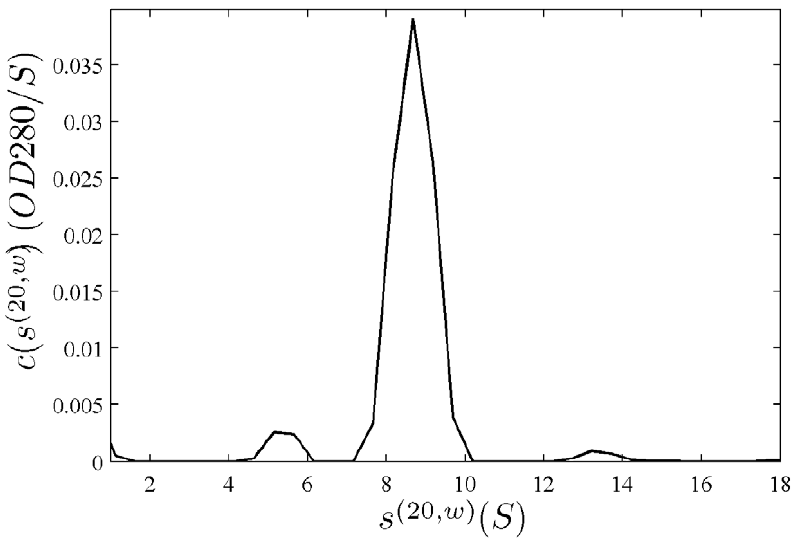
Figure 2. Sedimentation coefficient distribution for the global analysis of the absorbance data from the phosphorylase sample (Figure 1). Relative scaling factors a 2 = a 1 and a 3 = a 1 were 1.039 and 1.136 (see Eq. 19), indicating slightly different best-fit loading concentrations.